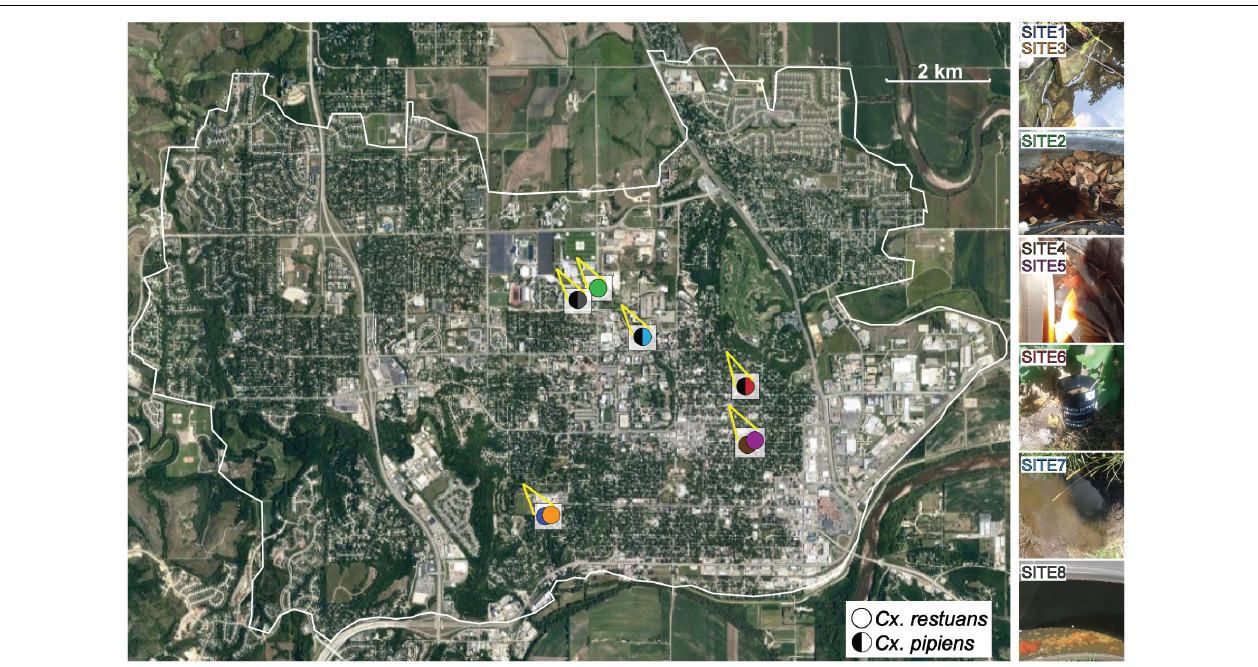
FIGURE 1 | Map depicting the collection sites of Cx. restuans and Cx. pipiens mosquito larvae and their breeding water in Manhattan, KS. Solid circles indicate Cx. restuans breeding sites while circles with half left black symbol indicate Cx. pipiens breeding sites. Cx. restuans breeding sites 1 and 4 were revisited in a May (site 3) and July (site 5) 2018,